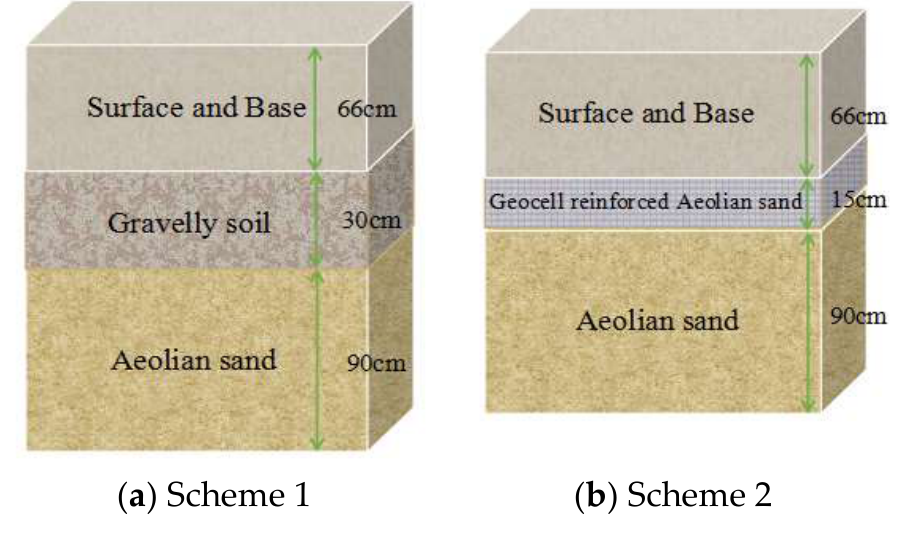
Figure 2. Schematic diagram of road structure.